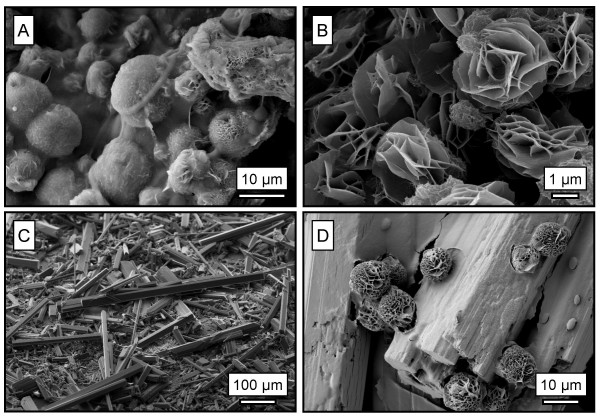
SEM micrographs of experimental samples. A: Rosettes of dypingite, covered with extracellular organic material, precipitated from groundwater in association with a biofilm of cyanobacteria. B: Rosette-like dypingite precipitated from Atlin wetland in the presence of cyanobacterial consortium. C: Slender prismatic crystals of nesquehonite precipitated from Atlin wetland water in the abiotic system. D: Dypingite rosettes on prismatic crystals of nesquehonite precipitated from wetland water with the addition of NaOH.